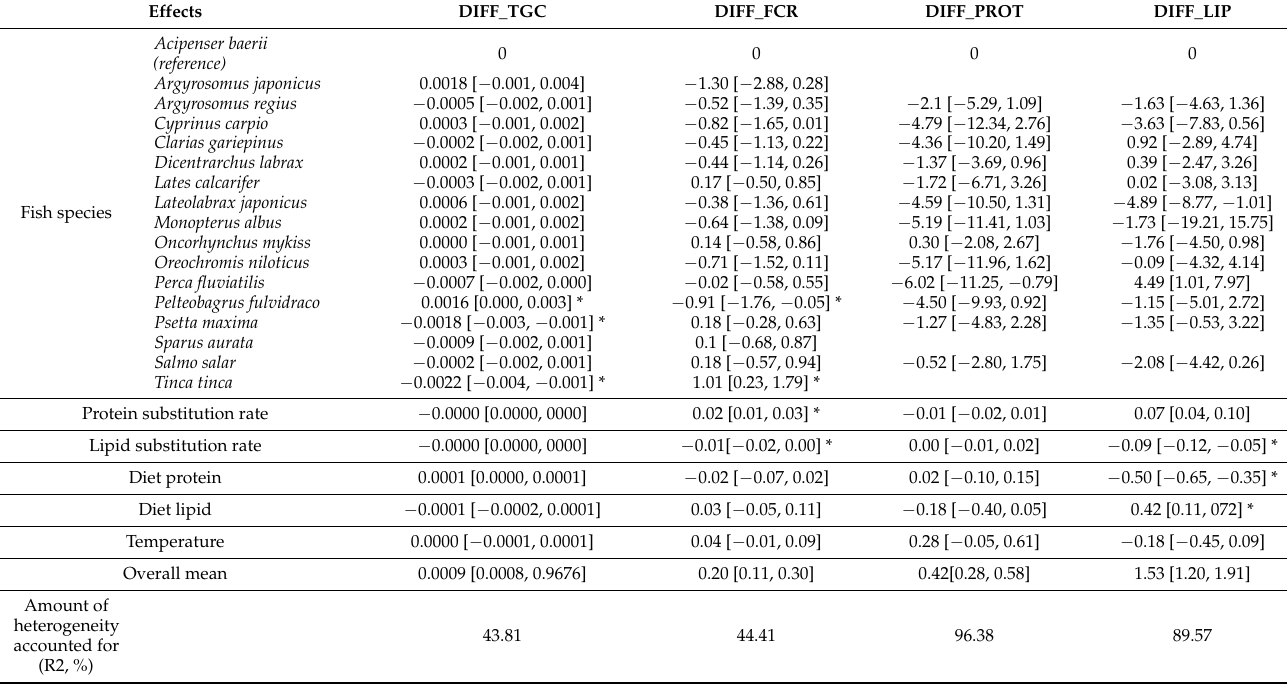
Table 2. Estimation of effects responsible for sources of heterogeneity across studies; * ( p <